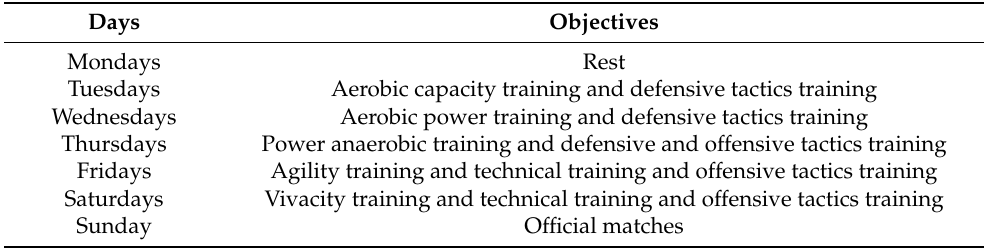
Table 1. Details of general training routine during the week performed by both control and experi- mental groups over the 8-week intervention.